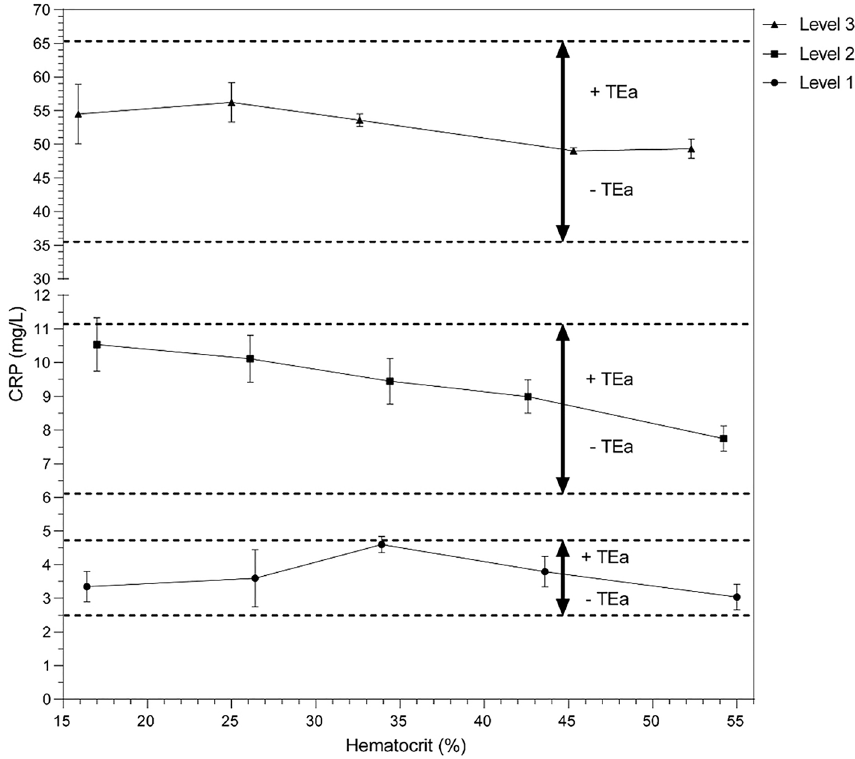
Figure 3. Effect of hematocrit on CRP. Pools from five patients with three different target concentrations were made. From each pool, a hematocrit dilution range was created and real hematocrit was measured with a Cell- Dyn Sapphire Hematology Analyzer (Abbott, Abbott Park Illinois, USA). Then, blood was spotted on DBS cards and stored for 1 day at room temperature before analysis. From a normal hematocrit of 45%, total allowable error (TEa) intervals were plotted with a dotted line.